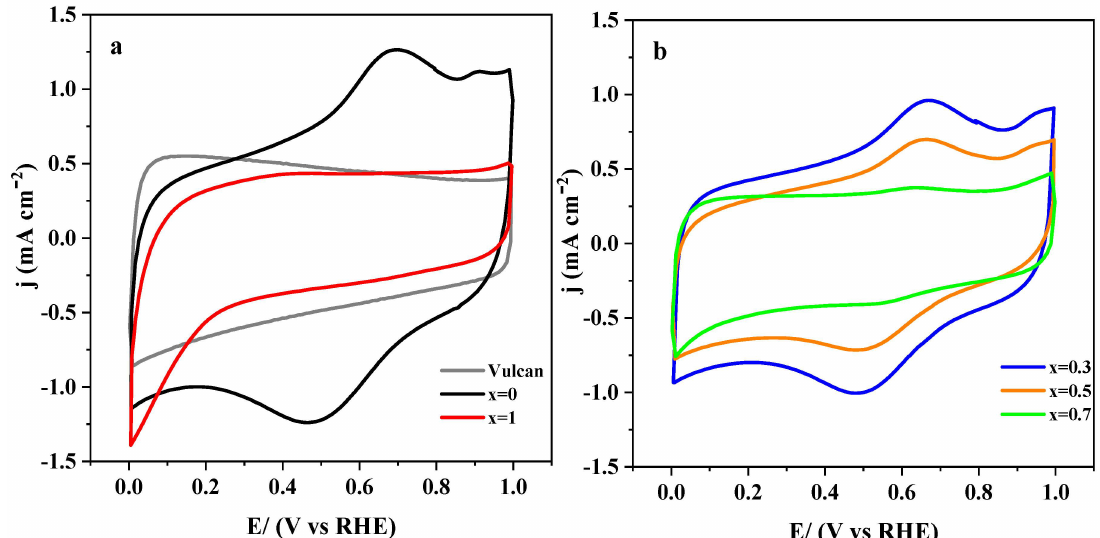
Figure 5. Cyclic voltammograms recorded in 0.1 M KOH medium saturated with N 2 for the samples: ( a ) Vulcan XC-72R (light grey curve) and the LaMn 1 − x Co x O 3 perovskites (x = 0 and x = 1) mixed with Vulcan (with 1:1 mass ratio) and ( b ) LaMn 1 − x Co x O 3 perovskites (x = 0.3, 0.5 and 0.7) mixed with Vulcan (with 1:1 mass ratio). Scan rate 50 mV / s.